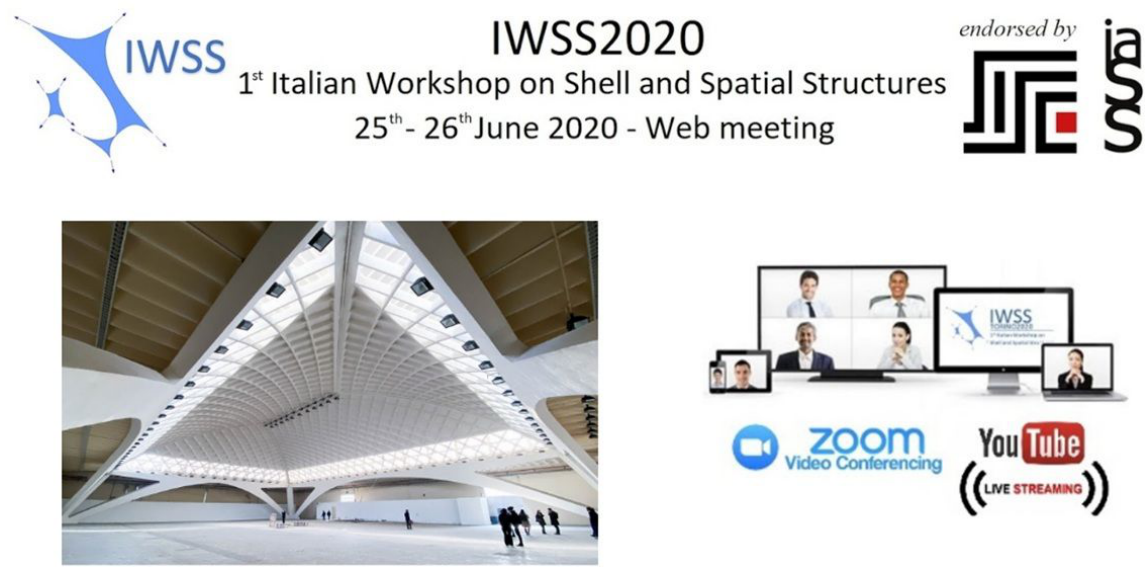
Figure 1: Header of the IWSS 2020 Homepage (top). Pavillon-C Exhibition Center in Turin by Riccardo Morandi, 1950 (bottom left); the Sabaudian city in northern Italy was the chosen conference site before COVID-19 outbreak. On-line platforms for IWSS2020 direct broadcast in June 2020 (bottom right)